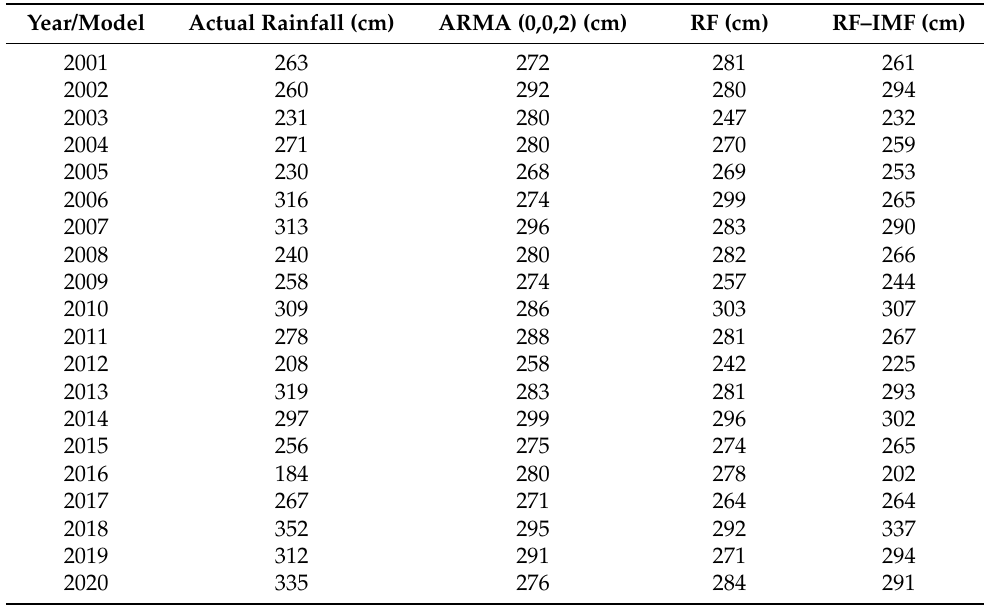
Table 2. Actual rainfall and predicted rainfall values.